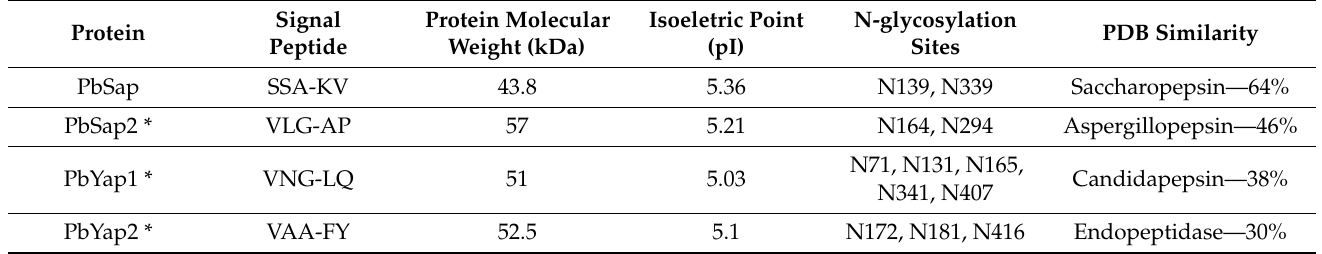
Table 3. Biochemical profile of aspartic proteases in P. brasiliensis .